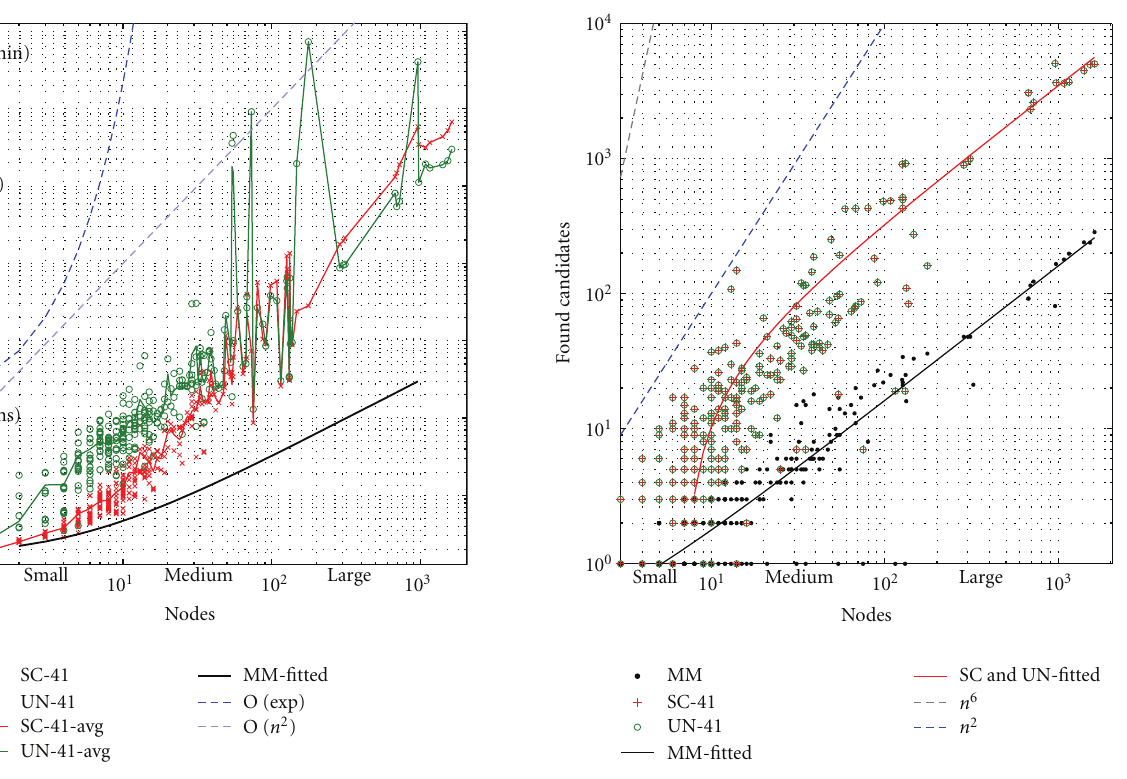
Figure 5: Number of found candidates by ISE algorithms for a large spectrum of BB nodes, where SC and UN are constrained to 4 inputs and 1